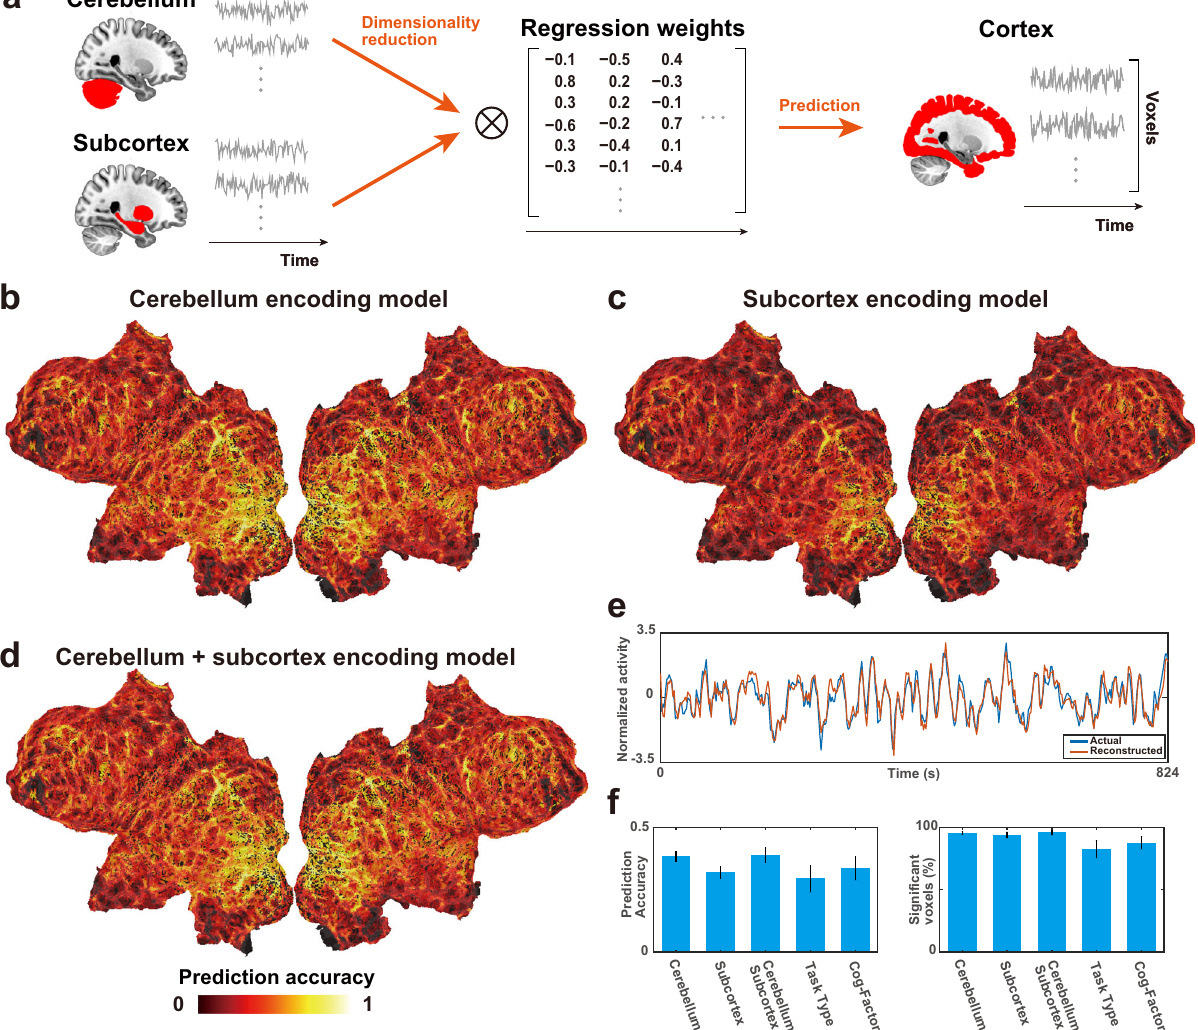
Fig. 6 Reconstruction of cortical activity from cerebellar and subcortical activities. a Reconstruction analysis of cortical activity from cerebellar and subcortical activities. Principal component analysis was applied to the original response matrices of the cerebellum and subcortex to reduce their dimensions to 2,000. These matrices were then used as feature matrices to predict cortical activity. b – d Cortical map of model prediction accuracy using the b cerebellum, c subcortex, and d cerebellum + subcortex encoding models, mapped on the fl attened cortical sheets of subject ID01 ( n = 412, P < 0.05, FDR-corrected; dashed line indicates the threshold). e Normalized actual (blue) and reconstructed (red) brain activity in the example cortical voxel of subject ID01, based on the cerebellum + subcortex encoding model. f Bar plots of mean prediction accuracy (left) and percent signi fi cant voxels (right) of cerebellum, subcortex, cerebellum + subcortex, task-type, and cognitive factor encoding models. Error bar, SD (calculated across subjects, n =